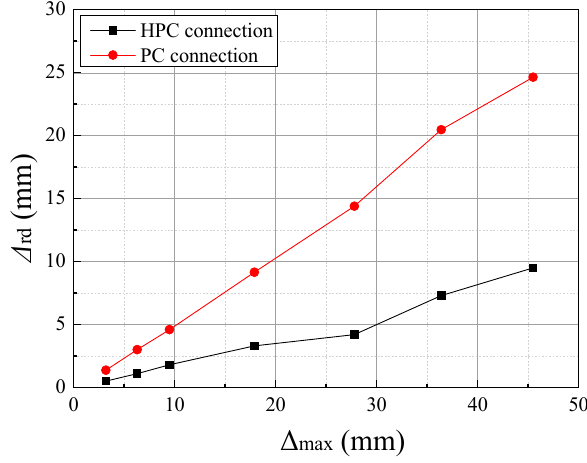
Figure 17. Displacement residual deformation rate.